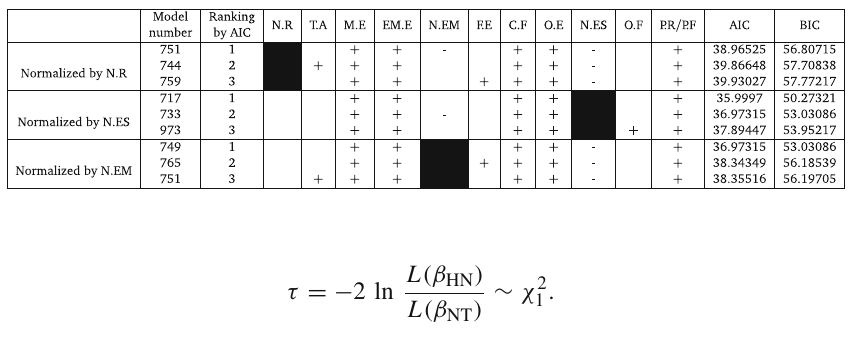
Table 3 Top models under different size